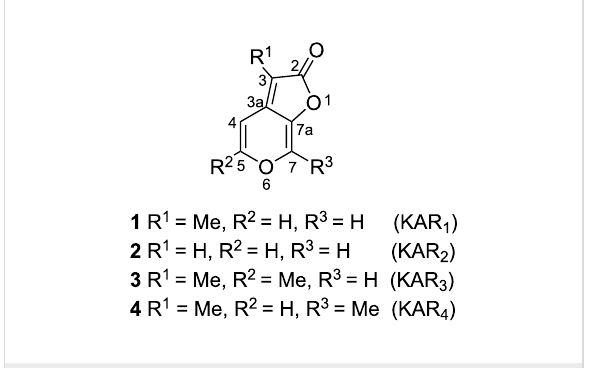
Figure 1: Structures of naturally occurring